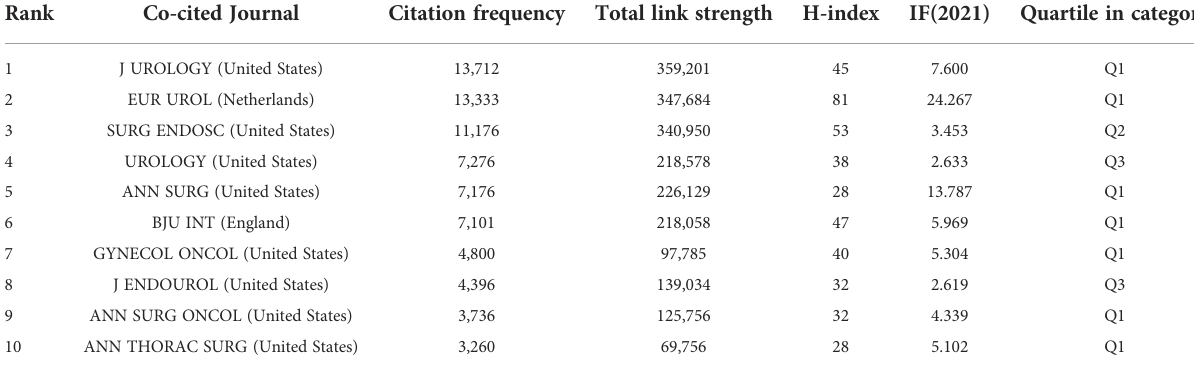
TABLE 4 The top 10 co-cited journals in citation frequency related to robotic surgery in